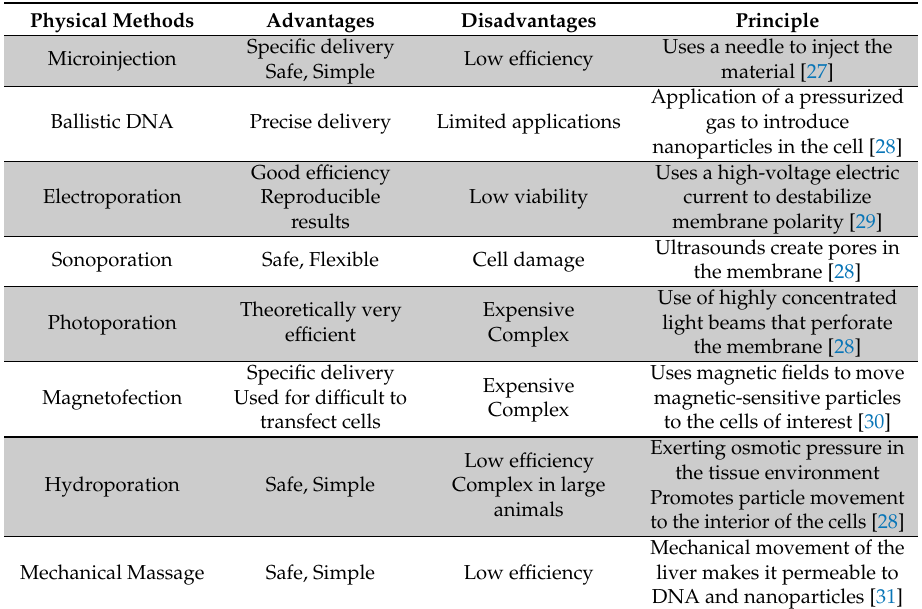
Table 2. Physical methods used for DNA insertion into cells with a summary of the main advantages, disadvantages, and the physical principle underlying the